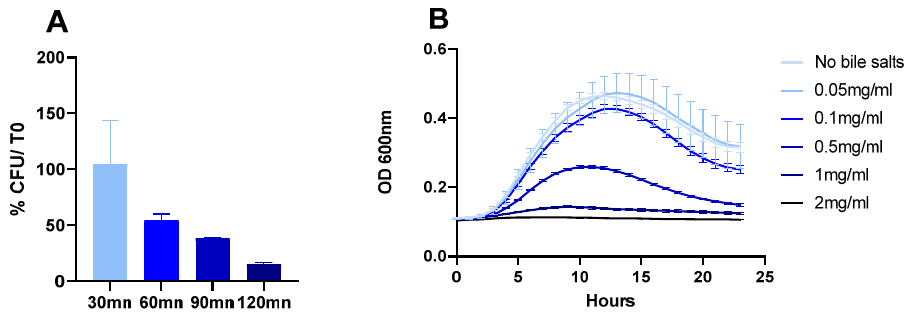
Figure 4. CNCM I-4884 tolerance to ( A ) pH 2.0 and to ( B ) conjugated bile salts.